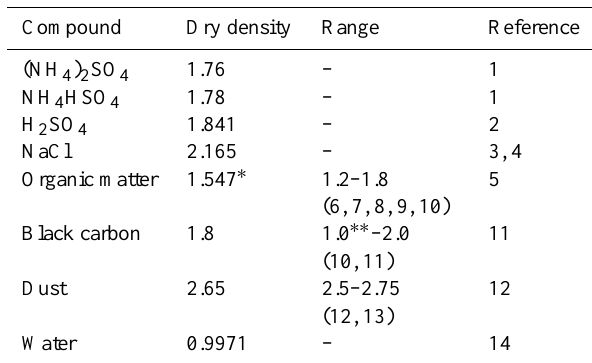
Table 3. Specific densities for the aerosol chemical